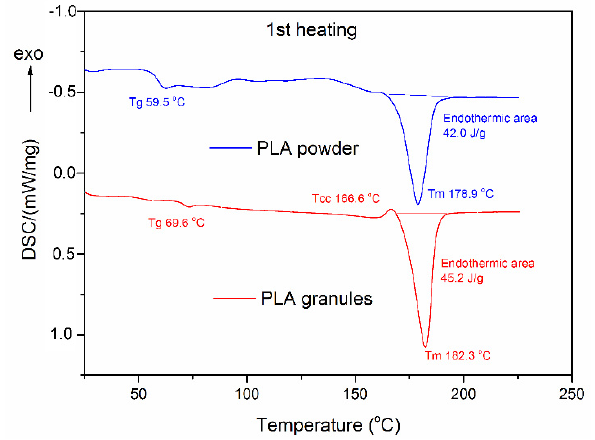
Figure 5. DSC traces of PLA in granular and powder states, obtained during the first heating scan.